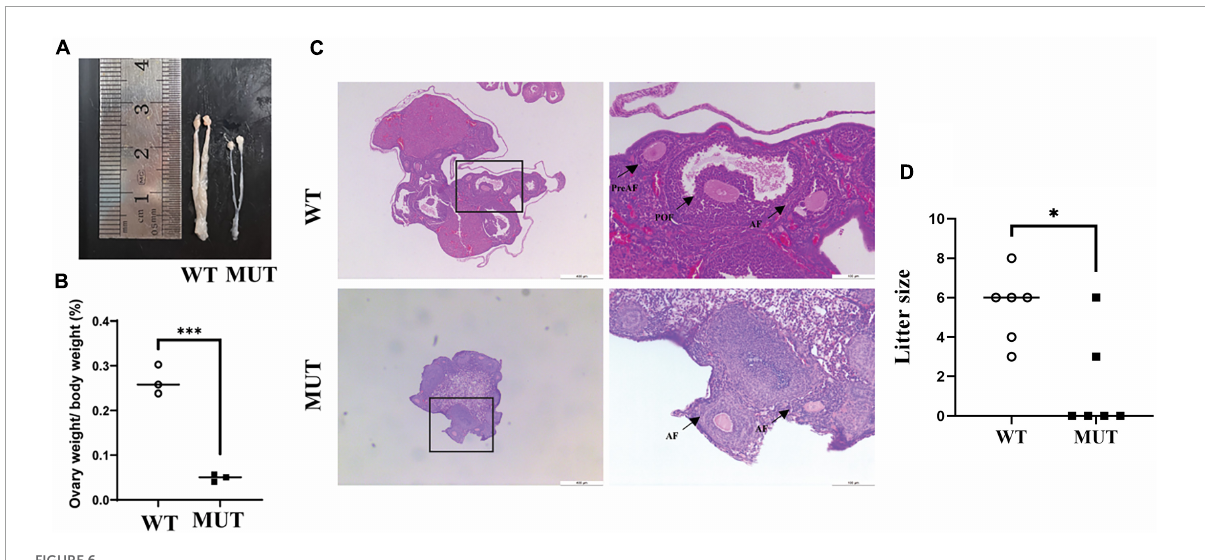
FIGURE6 Homologous mutation in the Timm8a1 gene led to a deficit in female reproductive organs. (A) The uterus and ovaries of MUT mice were morphologically smaller than that of the wild-type (WT) control at 24 weeks of age. (B) A comparison of the percentage of ovary weight to bodyweight between the WT and MUT mice (WT = 0.27 ± 0.03, n = 3; MUT = 0.05 ± 0.01, n = 3, ∗∗∗ p < 0.001). (C) H&E staining of the morphology of the ovary. The preantral follicles (PreAF), antral follicles (AF), and preovulatory follicles (POF) were marked in the figures. (D) A comparison of the litter size between the WT and the MUT mice. The Mann–Whitney test was applied to analyze the difference, suggesting a decrease in fertility and litter size in MUT mice compared to WT mice ( n = 6, ∗ p <